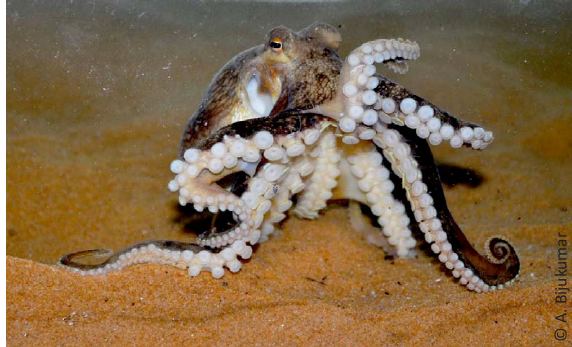
Image 3. A. marginatus (male) preparing for bipedal locomotion